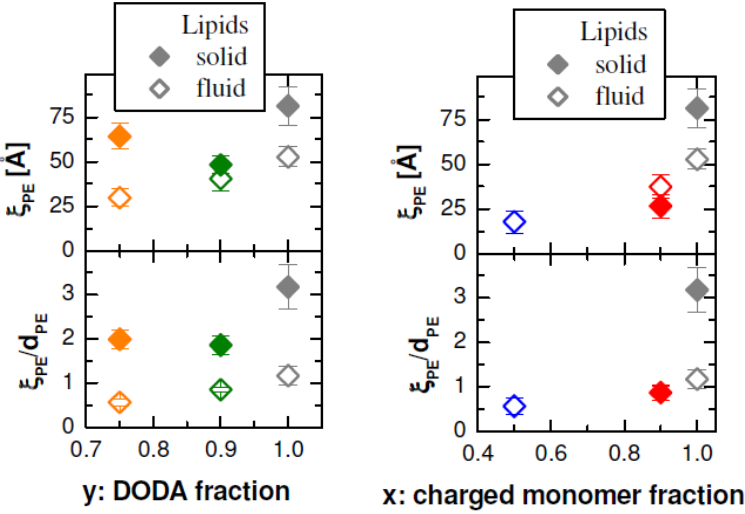
Figure 8. Left: DODA monolayers with adsorbed PE (PSS, P–TrisAA Top: Correlation length ξ linear charge density, respectively. Bottom: Ratio between correlation length ξ interchain separation d PE. ξ from the lipid phase indicated. Symbol assignment and color code is the same as Figure